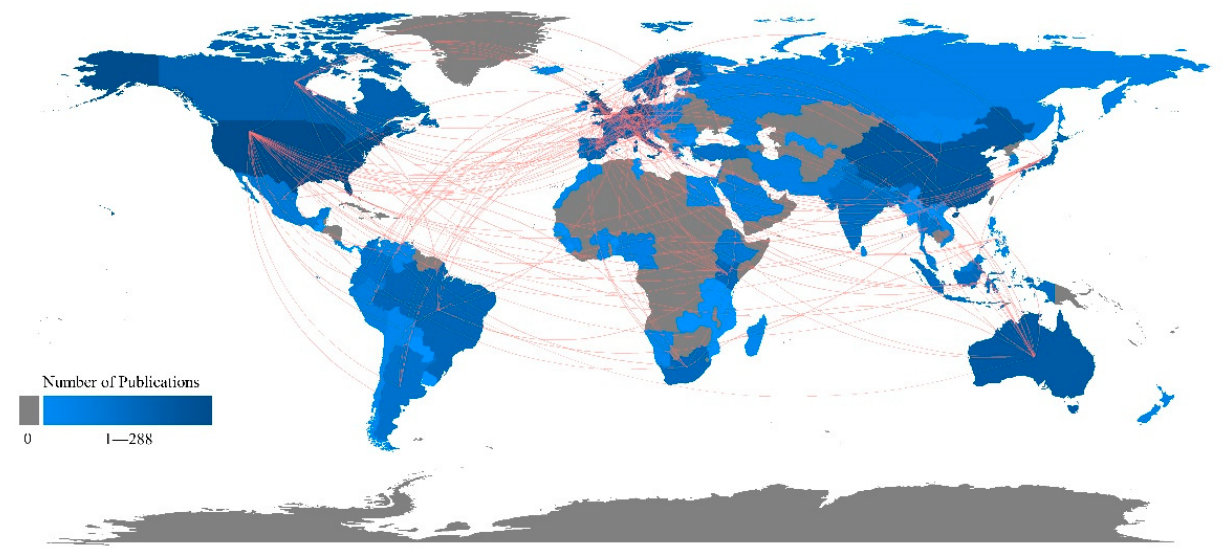
Figure 6. The cooperation network of the most productive countries.